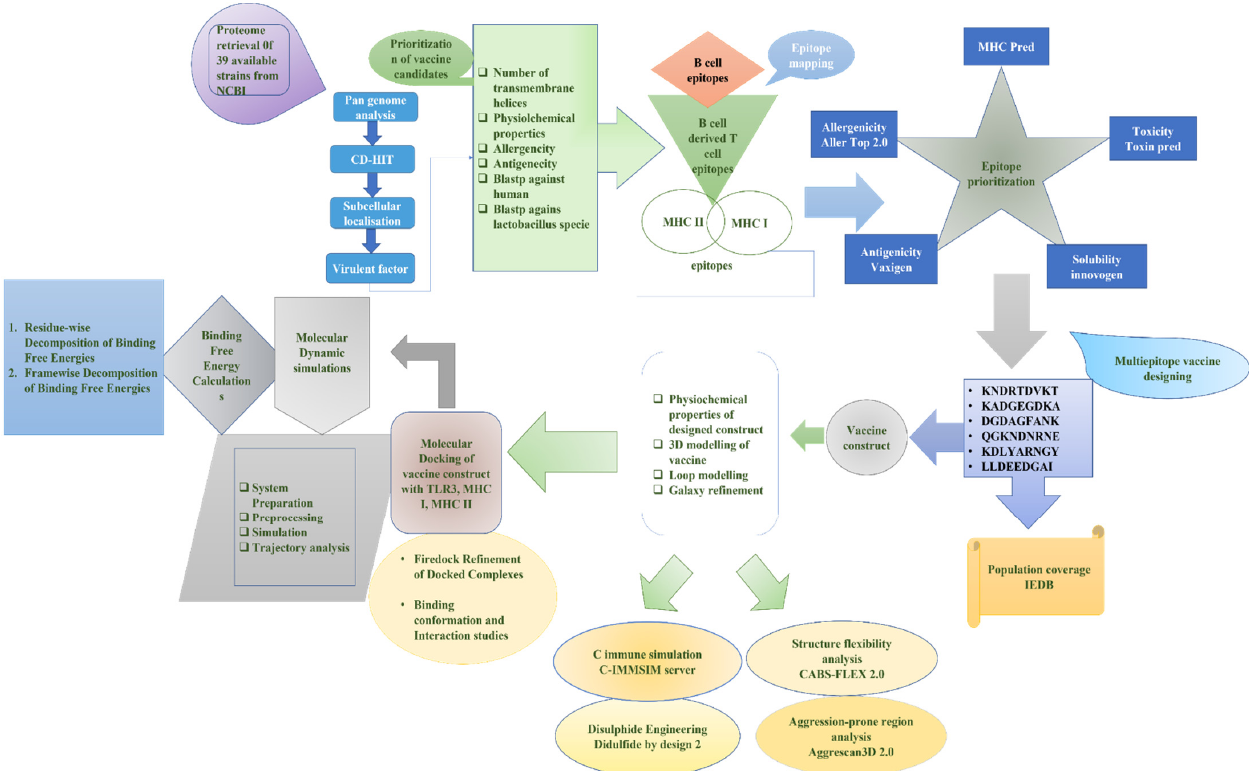
Figure 1. A complete methodology flow of the computational approaches designed for and applied to the protein-based MEBEPV.